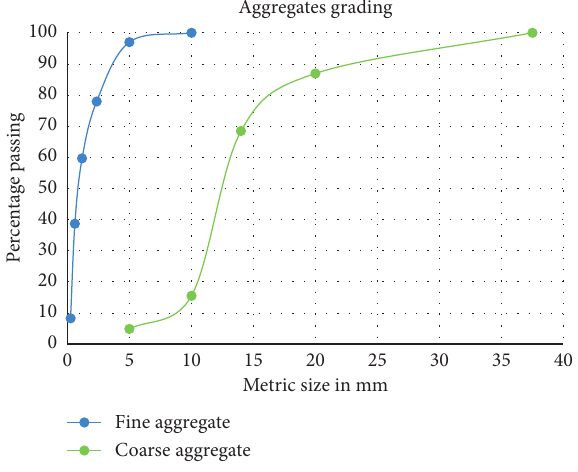
Figure 1: Sieve analysis for aggregates.